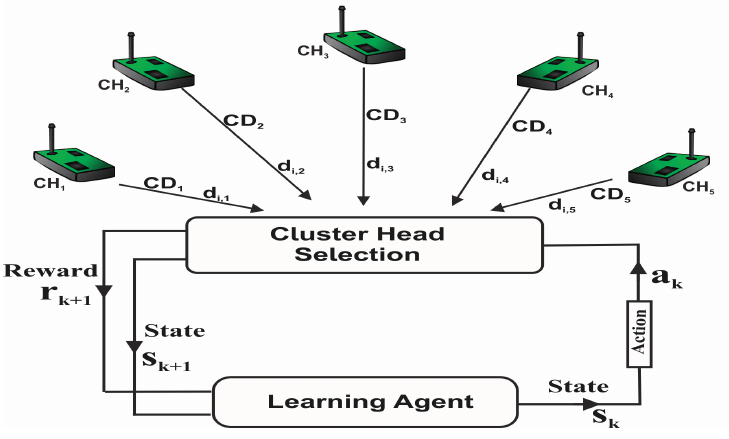
Figure 5. Model of reinforcement learning-based